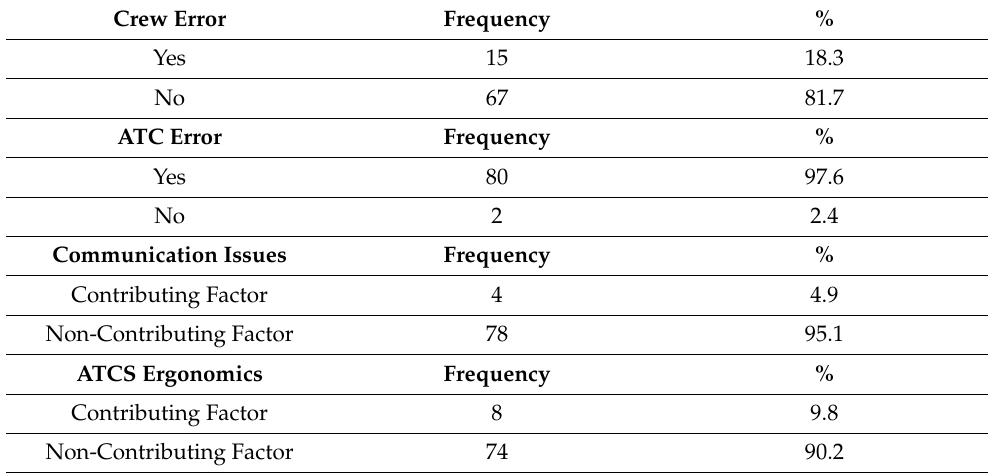
Table 4. Frequency distribution of the node states representing the causal factors of the